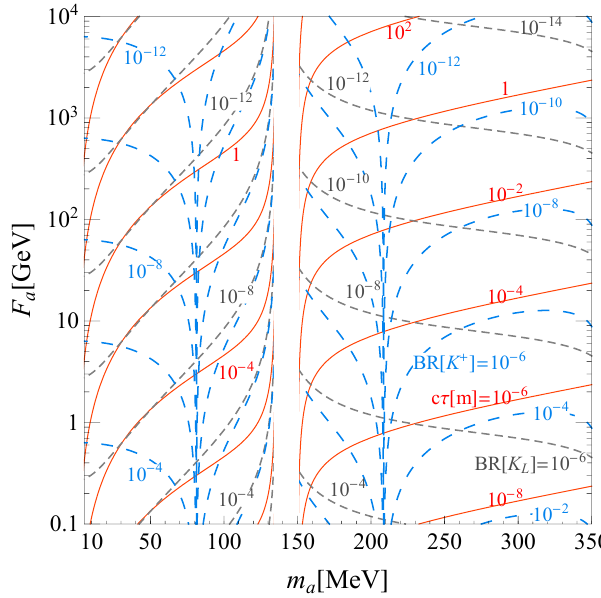
Figure 10 . Branching ratio of K L ! (cid:25) 0 a (in black dashed), branching ratio of K + ! (cid:25) + a (in light blue, dashed) and proper lifetime of the ALP in meters (in red) of the G ~ G coupled ALP. The mass range (cid:24) (135 (cid:0) 150) MeV is not plotted for a better